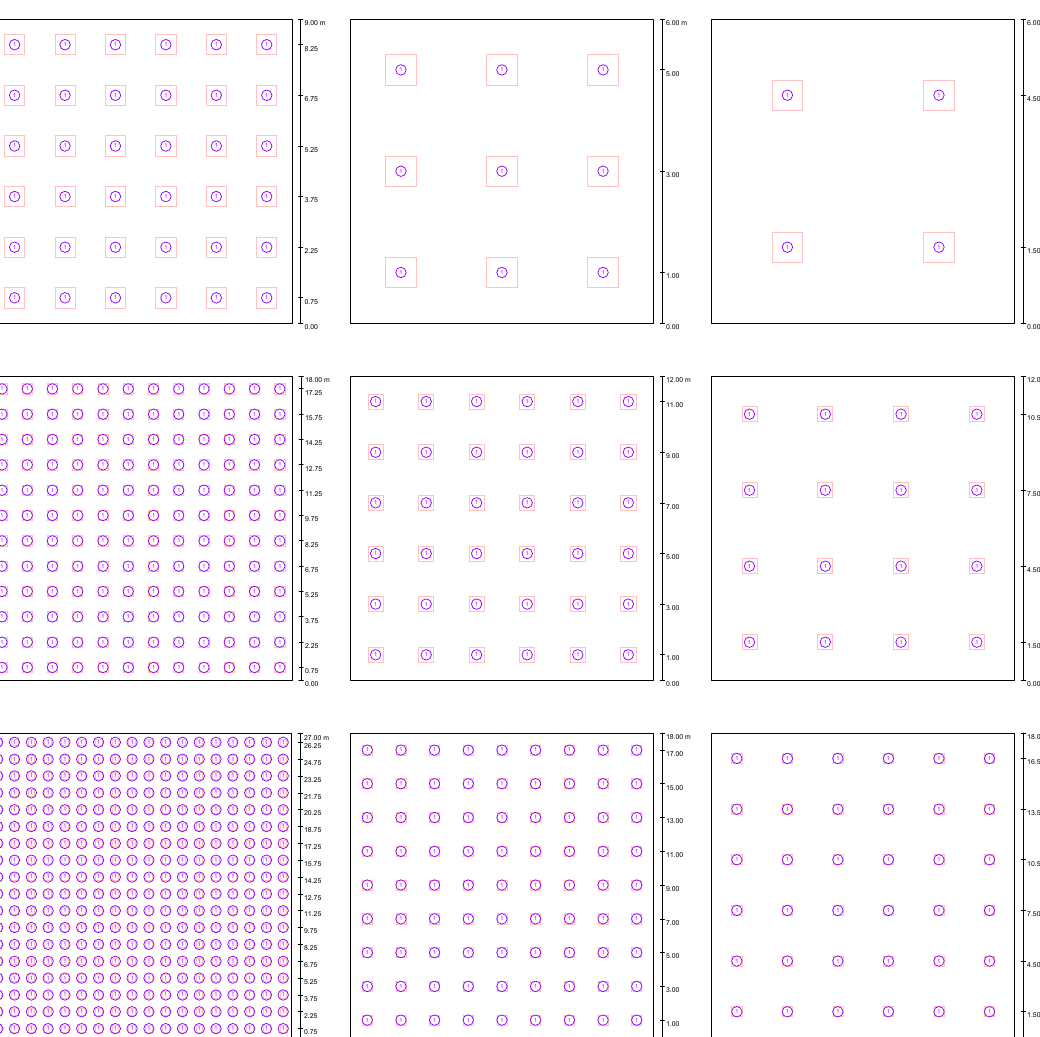
Figure 2. The luminaire layouts for the study. Top row, left: RI = 1.5, SH = 0.5; Top row, middle: RI = 1.5, SH = 1; Top row, right: RI = 1.5, SH = 1.5; Middle row, left: RI = 3, SH = 0.5; Middle row, middle: RI = 3, SH = 1; Middle row, right: RI = 3, SH = 1.5; Bottom row, left: RI = 4.5, SH = 0.5; Bottom row, middle: RI = 4.5, SH = 1; Bottom row, right: RI = 4.5, SH = 1.5.